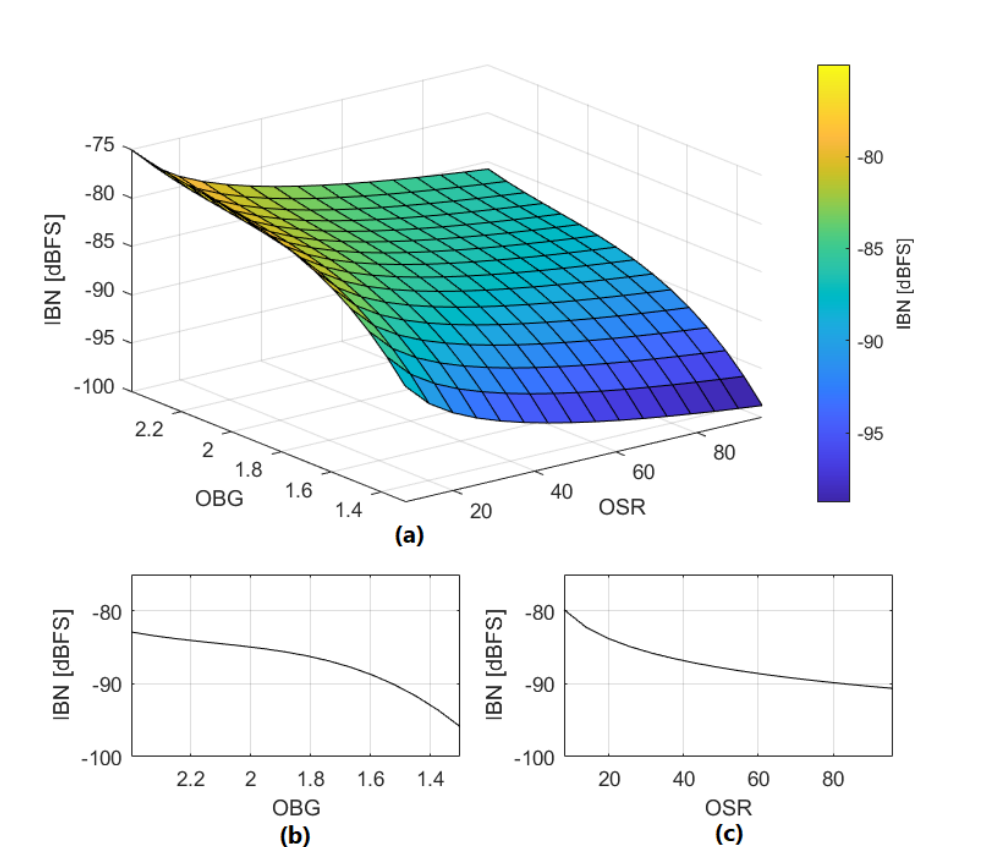
[ k ] | = 0.001. ( b ) IBN DAC dependence levels